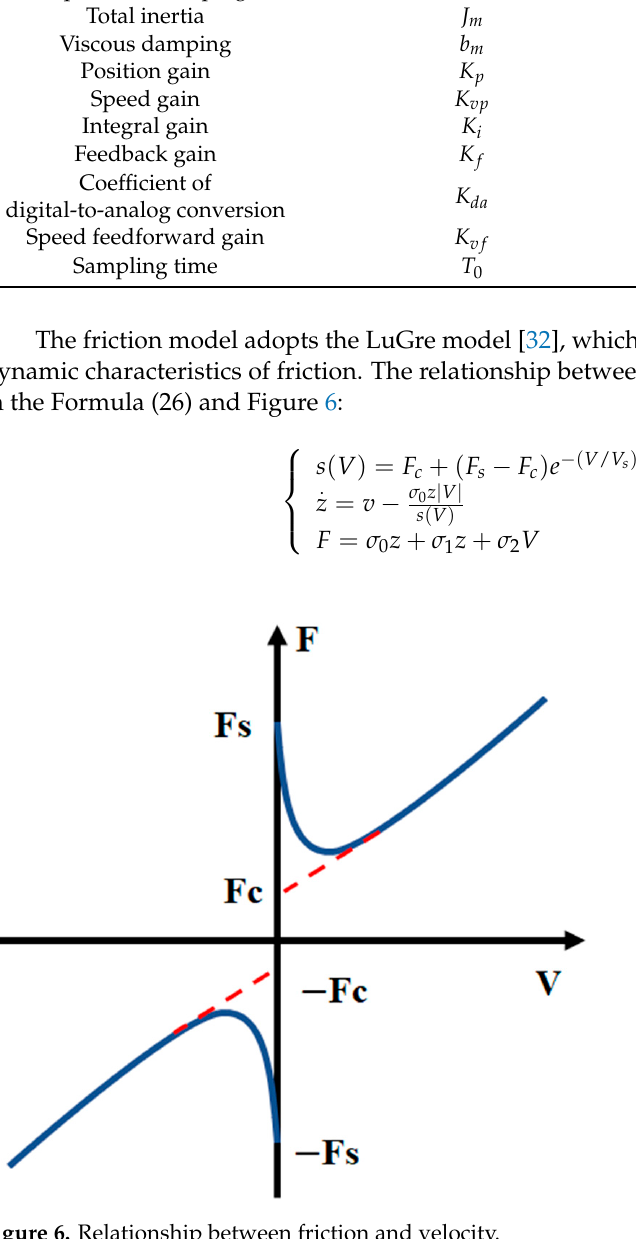
Figure 6. Relationship between friction and velocity. In (26), F s is the maximal static friction; F c is the Coulomb friction; z is the average elastic deformation of the bristles; σ 0 is the stiffness coefficient; σ 1 is the damping coefficient; σ is the viscosity coefficient. As shown in Table 2, the above parameters were